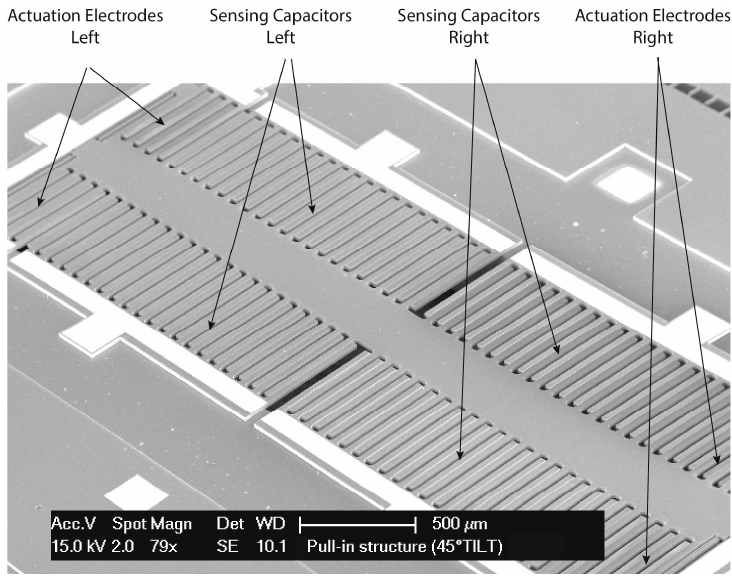
Figure 10. SEM image of a MEMS DUT.